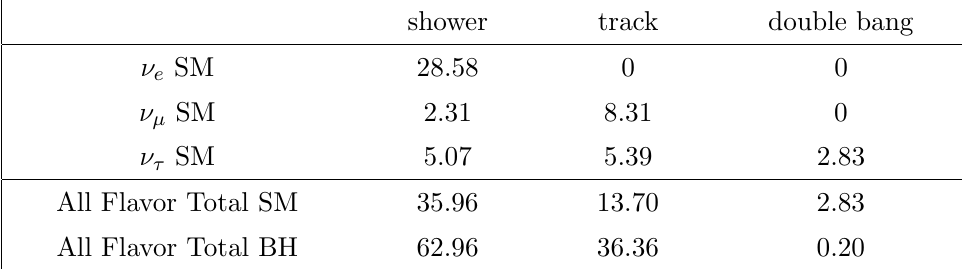
Table 2 . Expected number of events with di(cid:11)erent topologies from Standard Model and black hole production. We assume M ? = 3 TeV and 6 extra dimensions in the latter case. Double bangs are only produced in (cid:23) (cid:28) CC and black hole events. The neutrino (cid:13)ux is taken from eq.